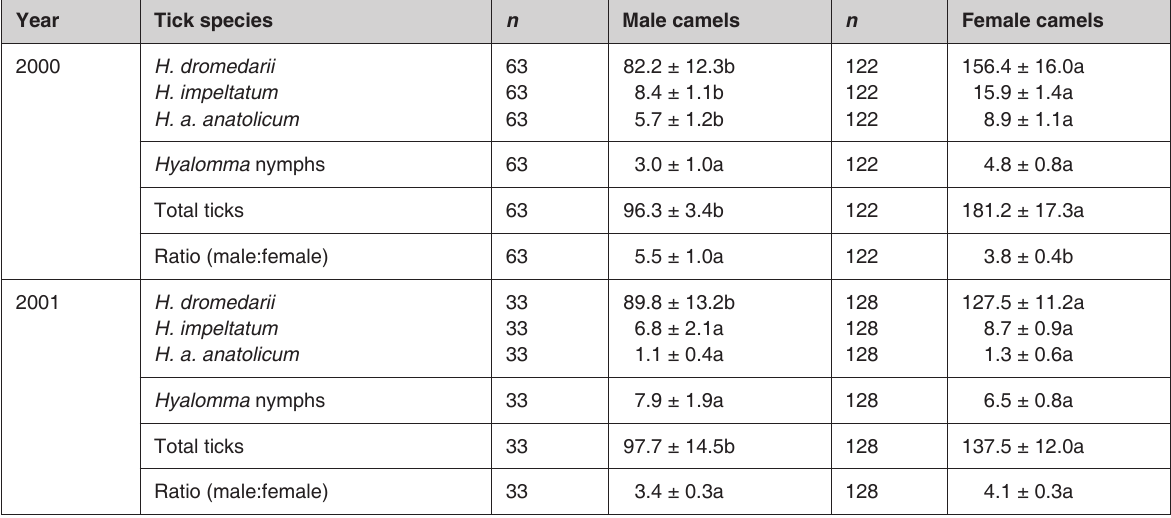
TABLE 4 Means ( ± SE) of ticks collected from male and female camels in River Nile State, Northern Sudan,